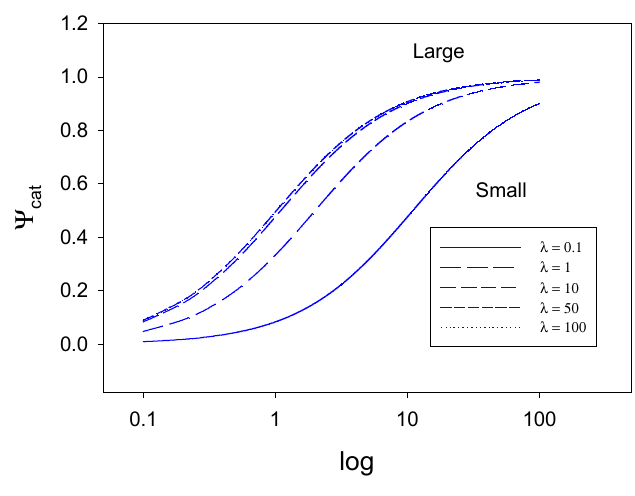
Figure 7. Variation of the normalized catalytic current with the parameter ρ which compares the rate of the surface reaction to the rate of substrate diffusion to the monolayer surface, according to the theoretical expression developed in eqn. 32 of the text.